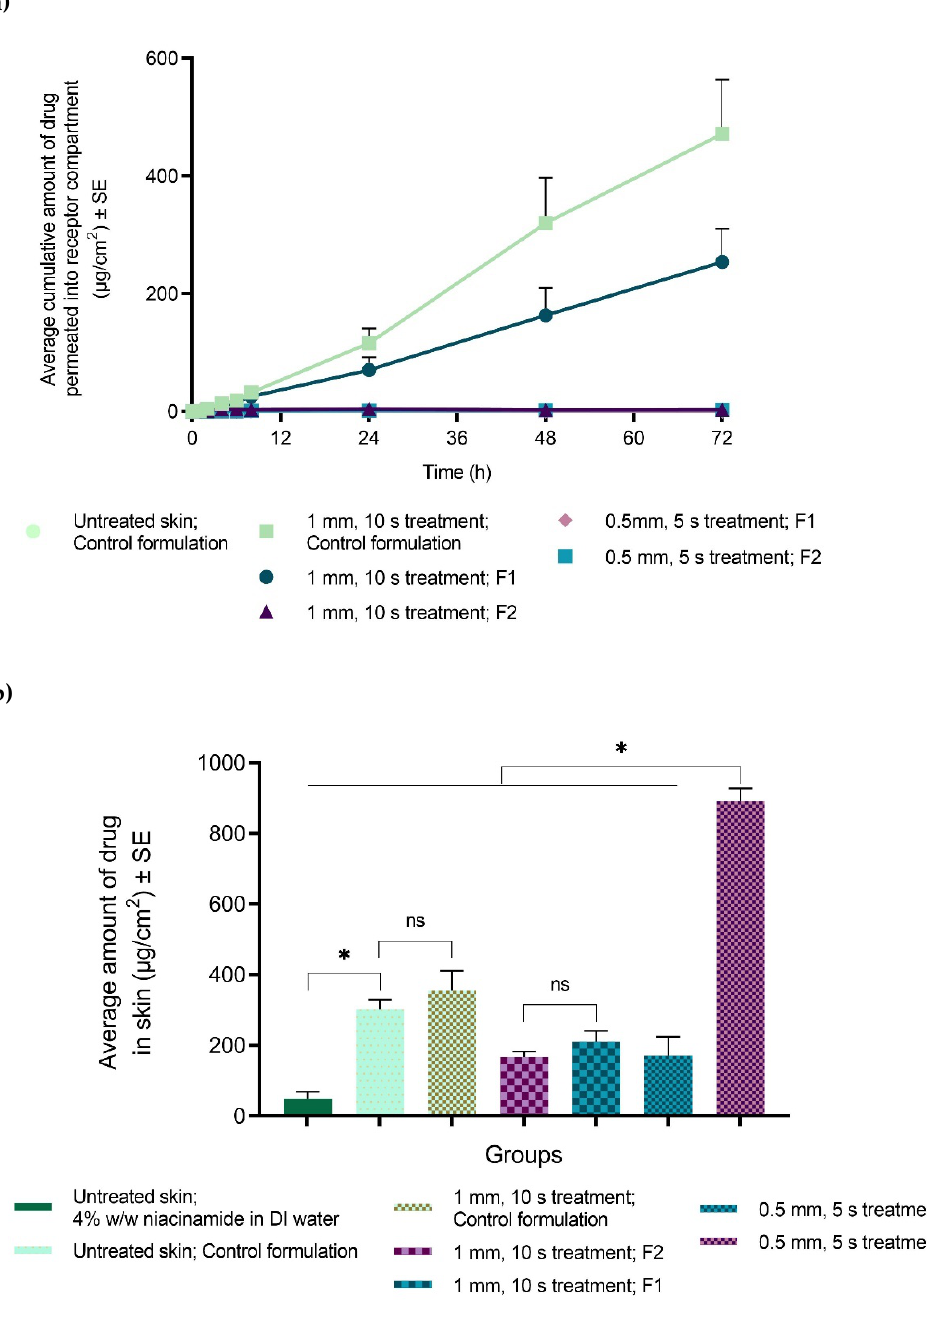
Figure 6. Average amount of niacinamide delivered ( a ) across porcine ear skin (receptor compartment and ( b ) into the skin (epidermis and dermis) after 72 h. Groups were either treated with Dr. Pen ™ Ultima A6 (1 mm needle length for 10 s or 0.5 mm needle length for 5 s, at 13,000 insertions / min) prior to the application of formulations or applied on intreated skin, as specified. ‘F1’ denotes 4% w / w niacinamide in an in situ gel formulation containing PLGA (EXPANSORB ® DLG 50-2A; “low” MW) and ‘F2’ denotes a similar formulation with PLGA (EXPANSORB ® DLG 50-8A; “high” MW). Control formulation does not contain PLGA. (Kruskal–Wallis test: *, p ≤ 0.05; n = 4).